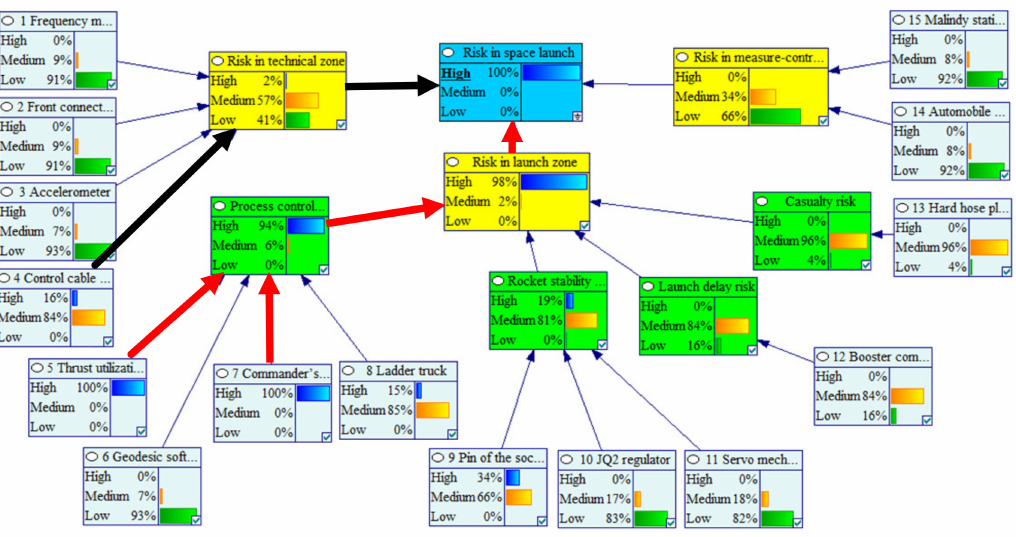
Figure 8. Reverse reasoning results of the